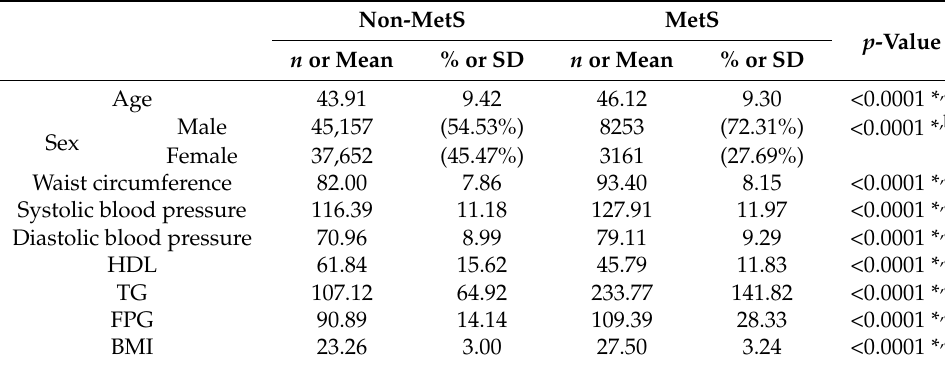
Table 2. Demographic characteristics of study subjects.